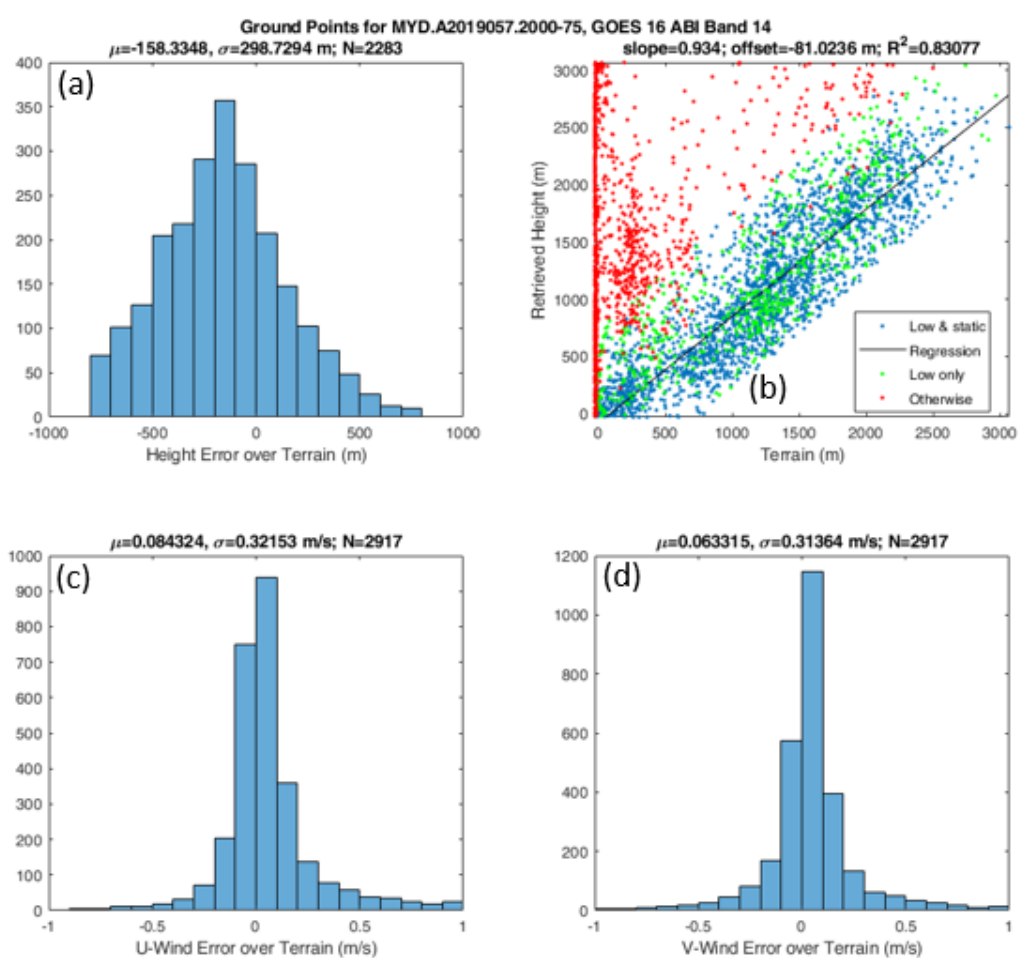
Figure 23. Clear-sky ground retrievals from the MODIS-GOES 3D-winds show the accuracies of retrieved heights ( a ) and velocities ( c ) and ( d ) for an infrared (IR) case. The mean µ and standard deviation σ over sample size N are computed for each histogram and the regression parameters ( b ) for retrieved height versus terrain height are reported for the ground-point class (“Low and static”). The MODIS granule is MOD2019057.2000.061 paired with ABI Band 14, CONUS scene time 2019/057 20:02.